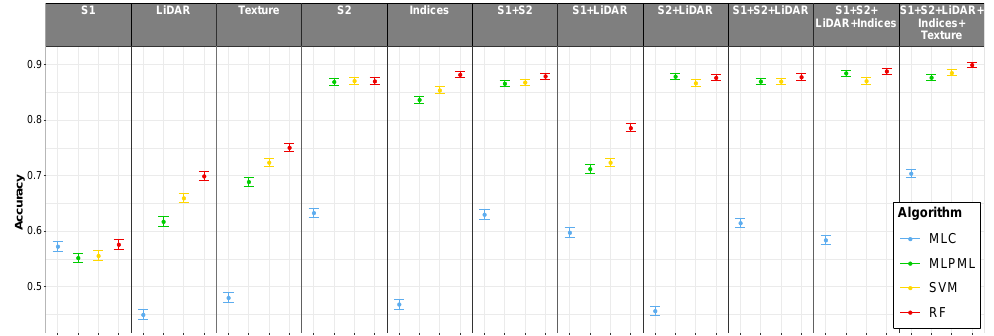
Figure 2. Classification accuracy by dataset and classification method with 95% confidence intervals. LOOCV by polygon ( n =